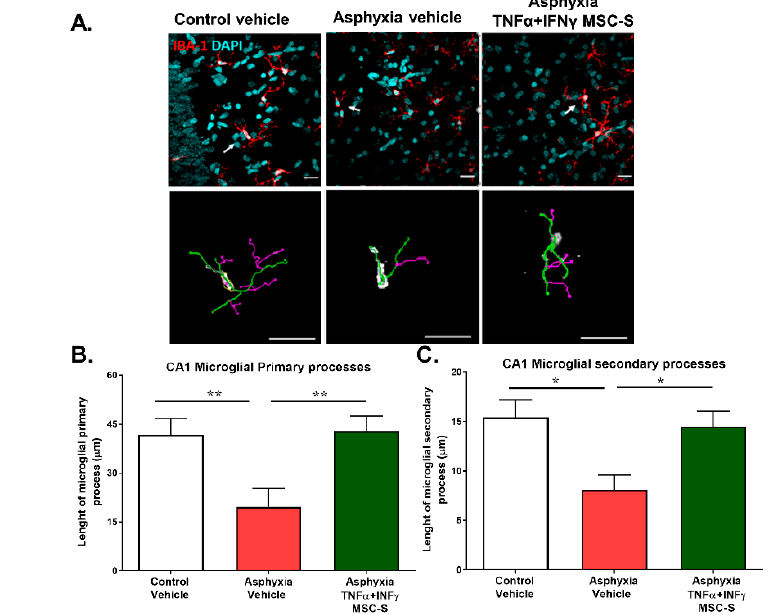
Figure 5. E ff ect of intranasal administration of TNF- α + IFN- γ -MSC-S on microglial process length in hippocampal CA1 region from PA-exposed rats at P7. ( A ) Representative microphotographs of immunofluorescence of IBA-1 (red) counterstained with DAPI (cyan) markers from controls and asphyxia rats treated with vehicle (AS) and asphyxia rats treated with-TNF- α + IFN- γ -MSC-S in the stratum radiatum of the CA1 hippocampal region at P7. White arrows indicate representative microglial cells depicted in the lower panel showing the three-dimensional reconstruction of their primary (green) and secondary (purple) processes, analyzed by FIJI software. (Bar: 20 µ m). Length of primary microglial processes. ( B ) Length of secondary microglial processes (IBA-1 + cells). ( C ) Data represent mean ± SEM. * p < 0.05 ANOVA and Benjamini, Hochberg, and Yekutieli post-test. ( B ) Primary processes; ** p < 0.005, Control vehicle (CS) v / s AS; * p < 0.05, AS v / s Asphyxia- TNF- α + IFN- γ